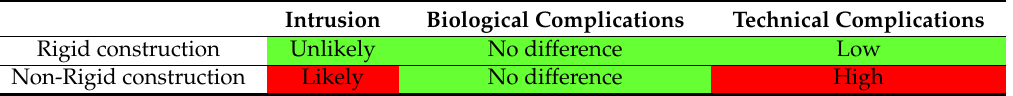
Table 8. Advantages and disadvantages of rigid and non-rigid